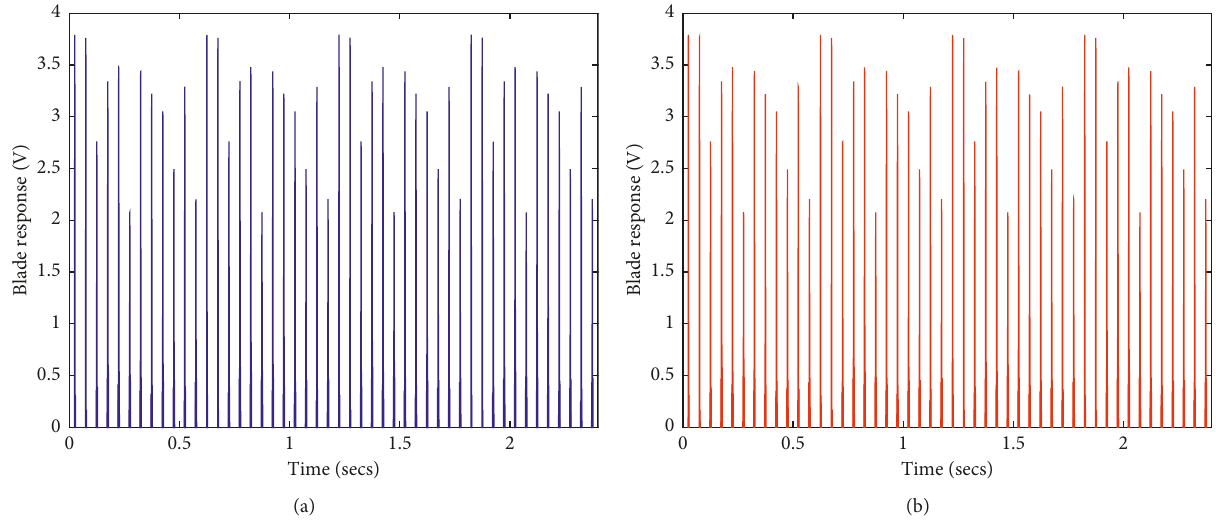
Figure 11: AECS reconstructed BTT signals of all blades for a speed of 100rpm. (a) Undamaged and (b) damaged cases.